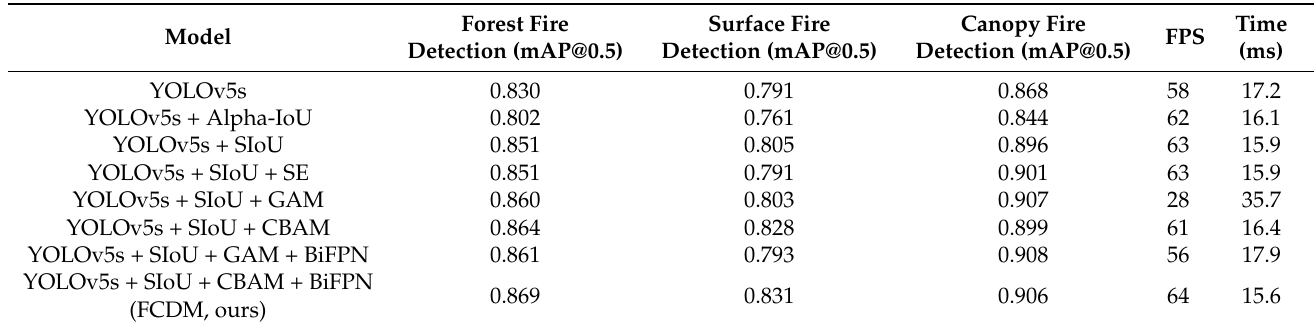
Table 4. Experimental results of the